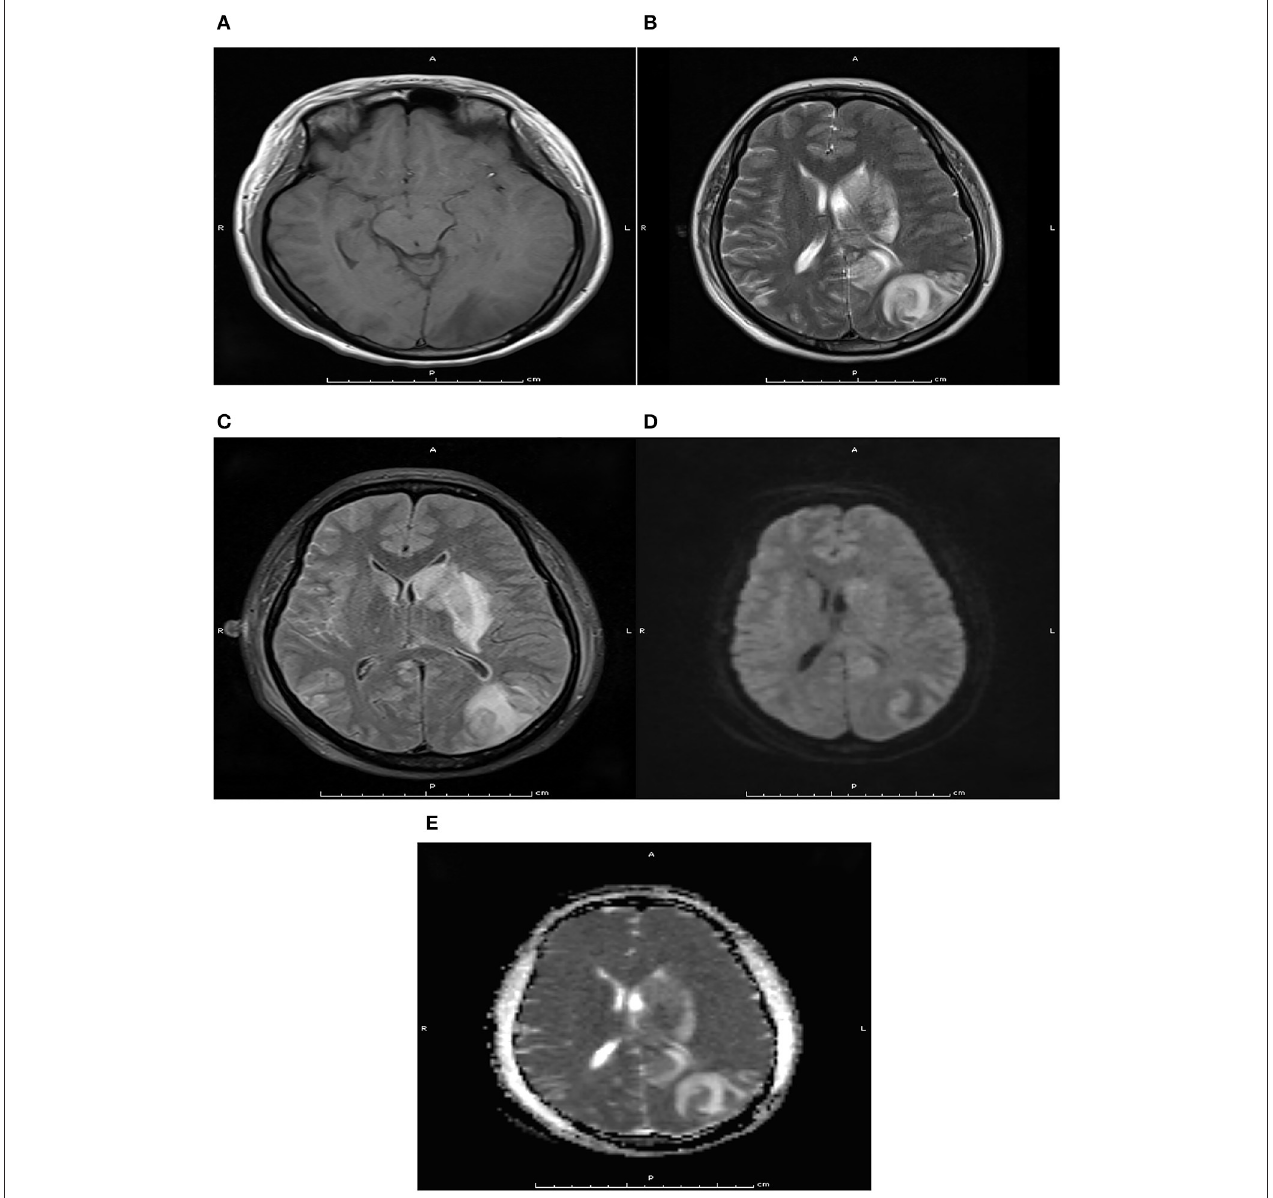
FIGURE 2 | Pre-treatment axial magnetic resonance imaging at T1WI (A) , T2WI (B) , Flair (C) , DWI (D) , and ADC (E) sequence. Pre-treatment axial magnetic resonance imaging indicated there were long T1 and T2 signals, flair hypersignal, mild limited DWI, and ADC hypersignal in the left occipital lobe and basal